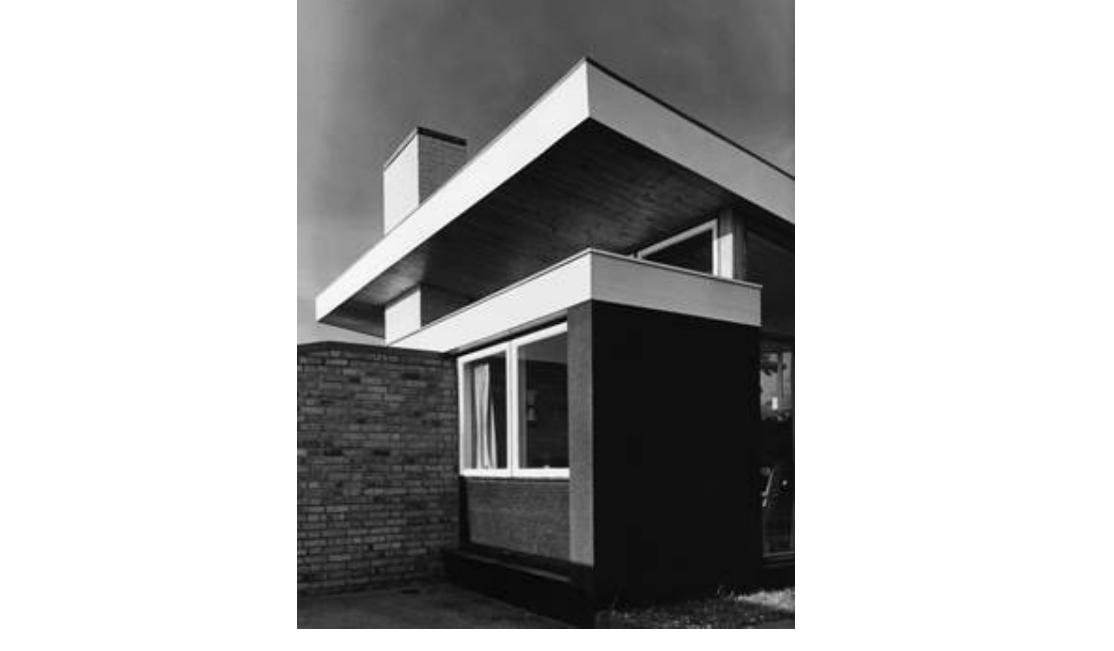
Figure 1. Admission and Treatment Unit, Fair Mile Hospital, Wallingford, Oxfordshire, corner detail of the common room showing the roof supported on a timber frame, 1956 (Source: Architectural Press Archive / RIBA Collections, RIBA Ref No: RIBA56471)